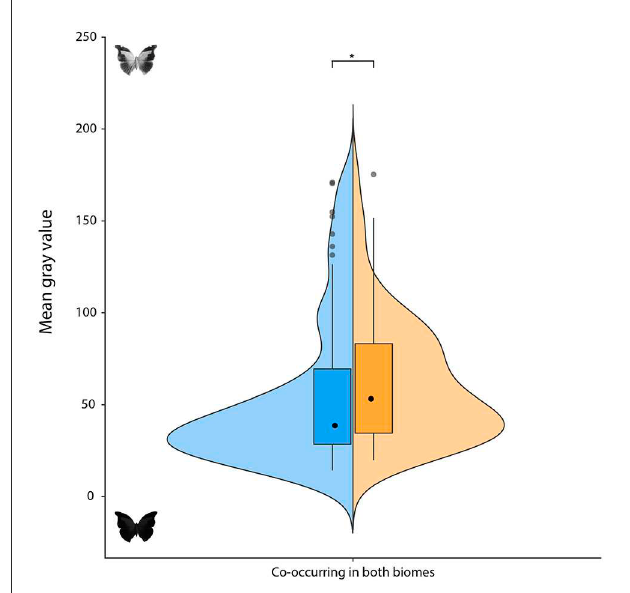
FIGURE2 Mean gray value of butterflies co-occurring in both biomes (tropical rainforest and xeric white forest). Other conventions as in Figure